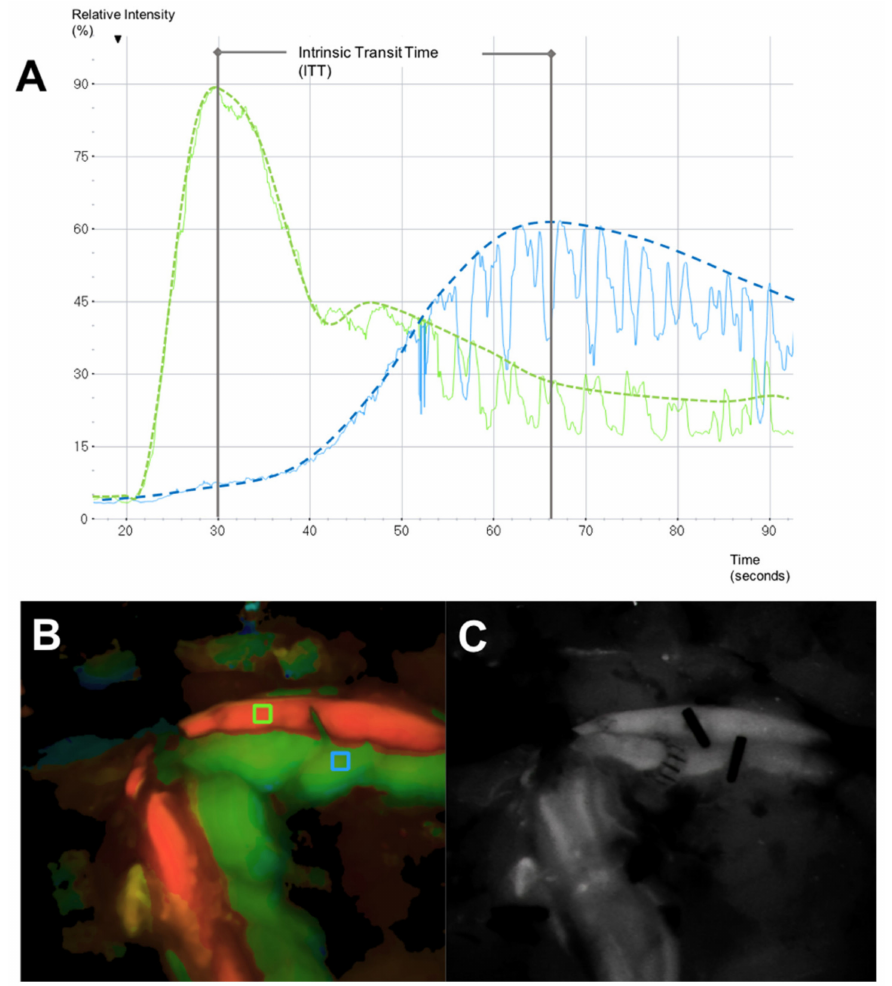
Figure 2. ( A ) Microvascular Indocyanine Green Angiography (mICG-A) flow curves in two selected regions of interest (ROI) (green curve: arterial flow, blue curve: venous flow). The spikes are artefacts caused by respiratory movements. ( B ) Delay Map obtained with FLOW800 illustrating both ROIs (green ROI placed at the artery, blue ROI placed at the vein) and picturing the two flow curves. ( C ) Gray-scale map of fluorescence intensity (Intensity Map) illustrating both artery and vein after